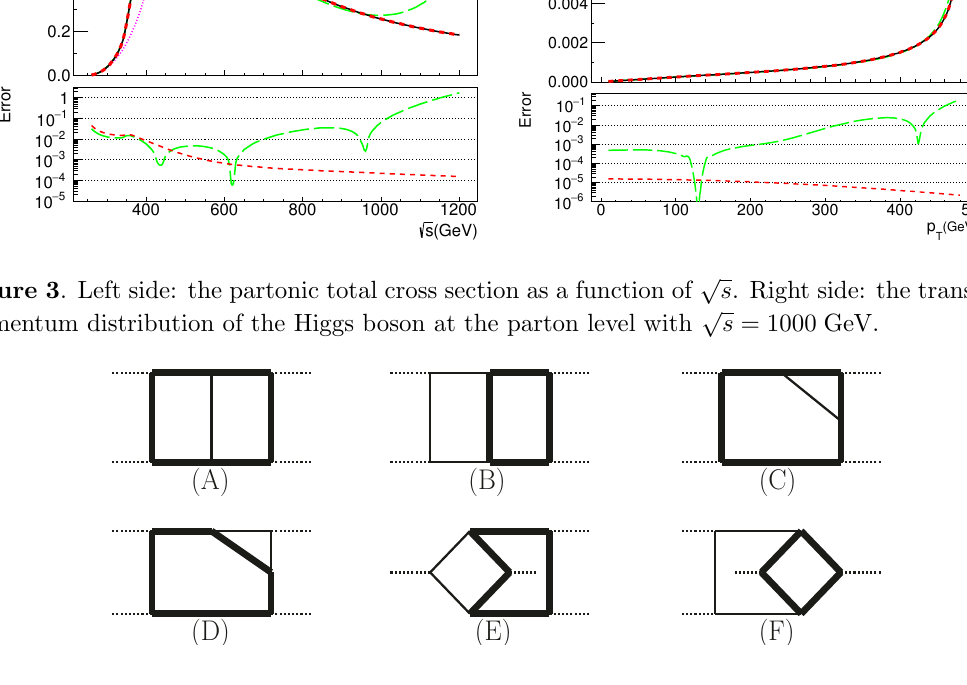
Figure 4 . Topologies relevant to the NLO QCD corrections to Higgs boson pair production after expansion in the small m h limit. The thick lines represent massive propagators (top quarks), while the thin lines represent massless propagators (gluons). The external legs (dashed lines) are all